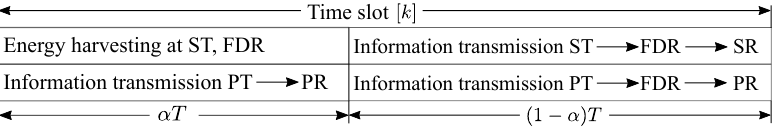
Figure 2. Time-switching relaying (TSR)